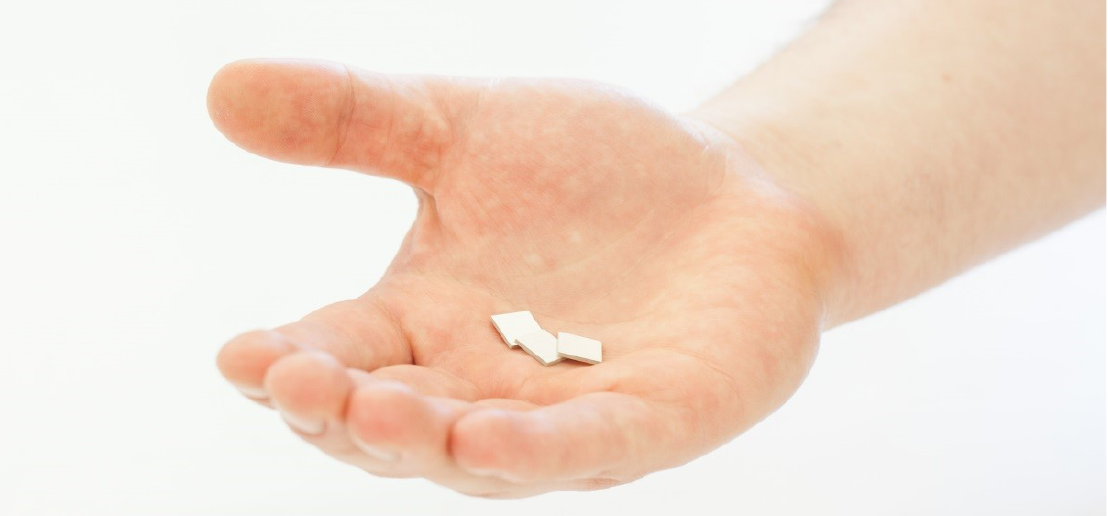
Figure 5: Piezoceramic sensing systems for cure